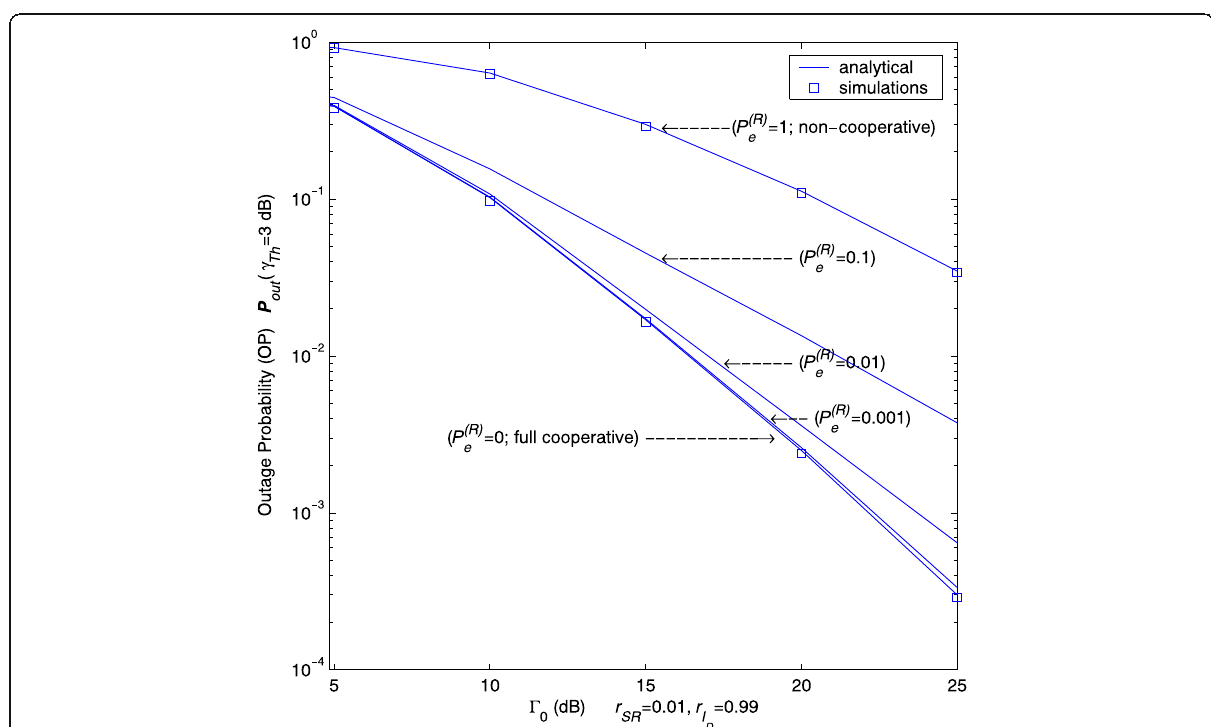
Fig. 2 The outage probability, P out ( γ Th ), for various P ð R Þ ¼ 0 : 99), and thermal noise, with N correlated CCIs ( r I D